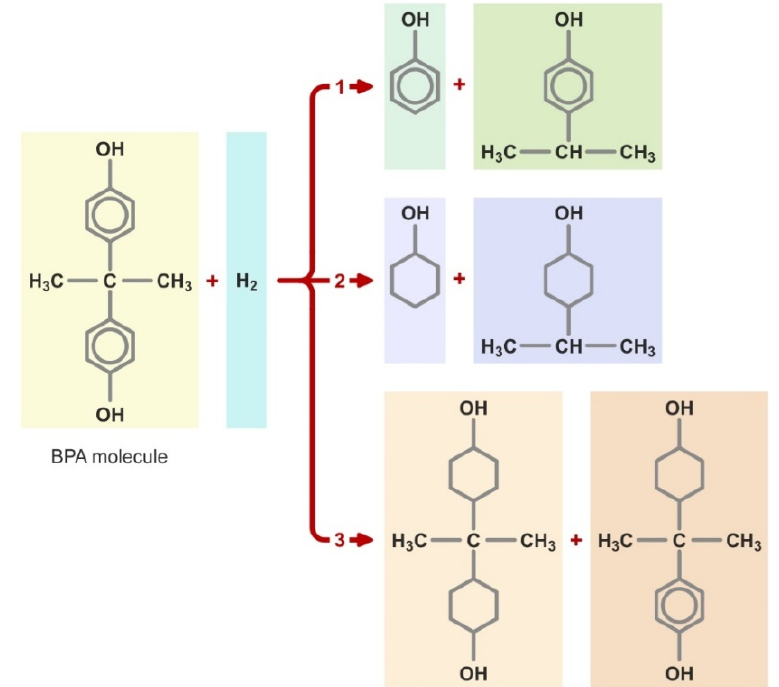
Figure 2. Hydrogenation pathways of BPA.